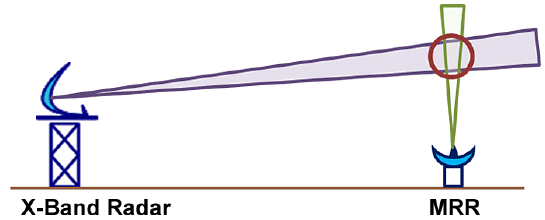
Figure 7. Sketch of the set-up for calibration of X-band radars with MRR.